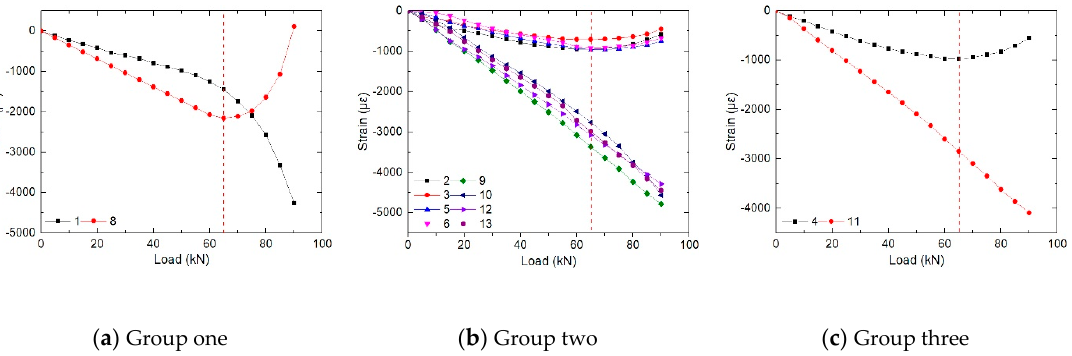
Figure 5. Typical strain-load curves of the third non-defective compressive sample (CD0-3).